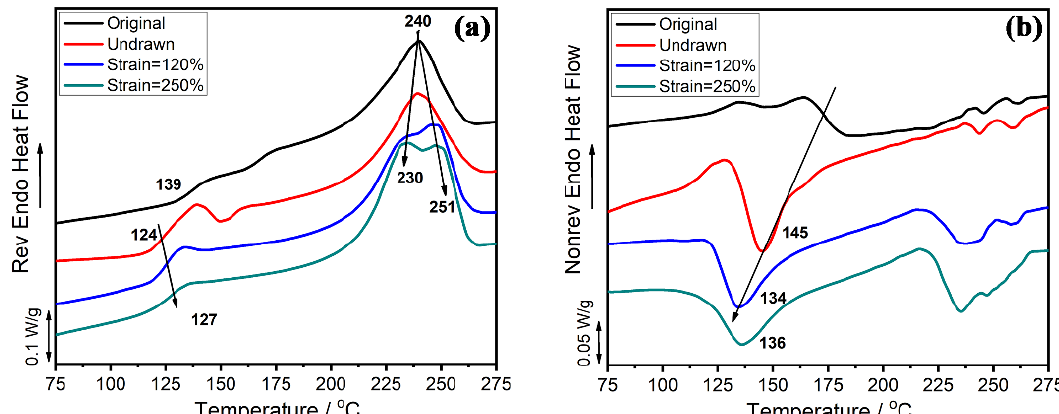
Figure 5. The first heating curves of PAPACM12 at different strains with modulated differential scanning calorimetry (MDSC): ( a ) reversible signal, ( b ) nonreversible signal.